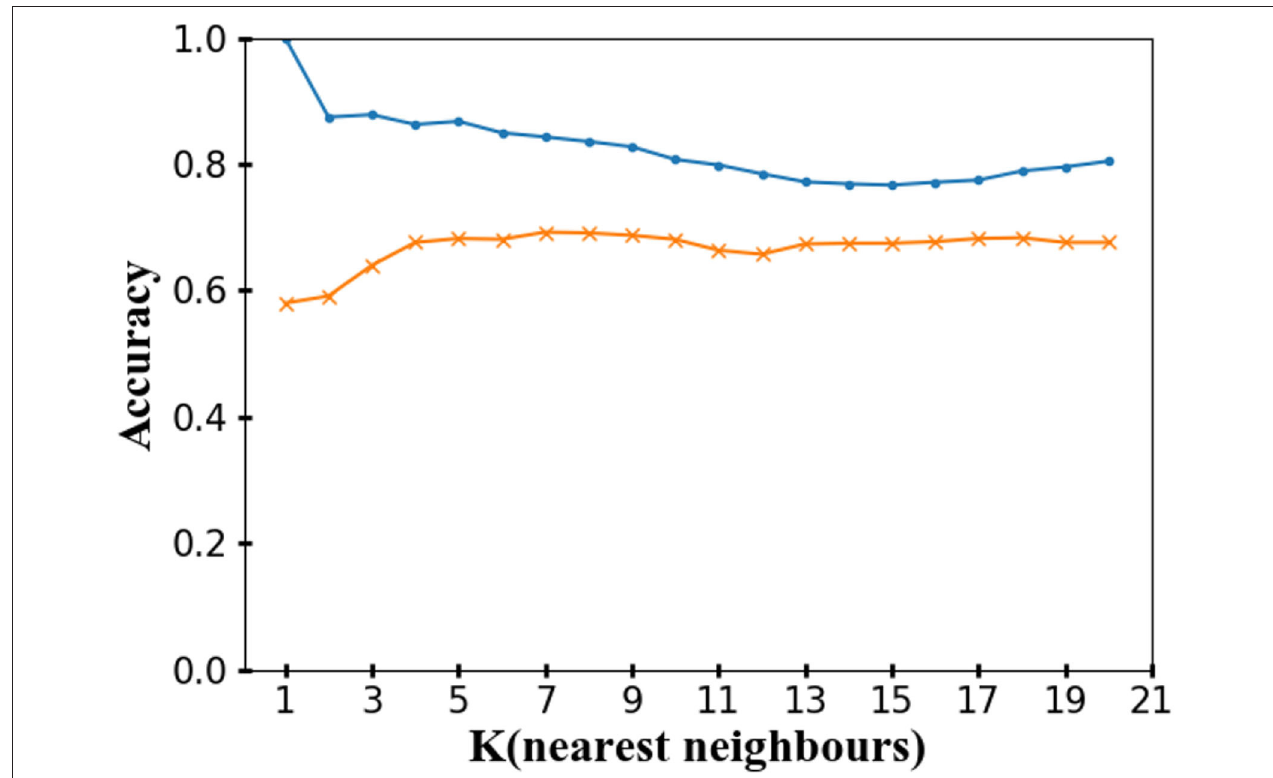
TABLE 2 | Parameters for Machine learning models trained using dataset of 2D lattice network. KNN SVM MLP-NN Description Value Description Value Description Value K 5 Regularization Parameter 10 Weight Function Uniform Kernel EBF Distance Metric Euclidean Gamma 0.5